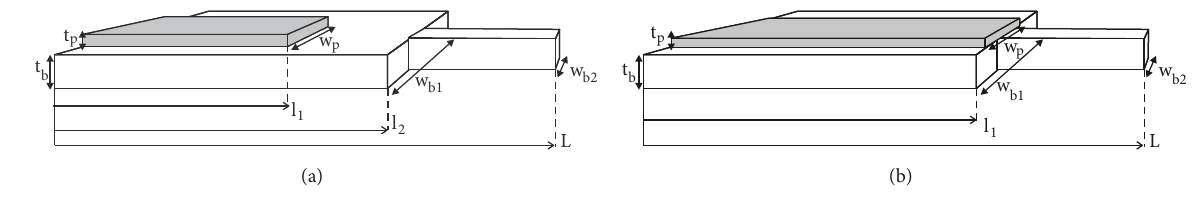
Figure 1: Schematic representation of the (a) triple span and (b) double-span piezoelectric